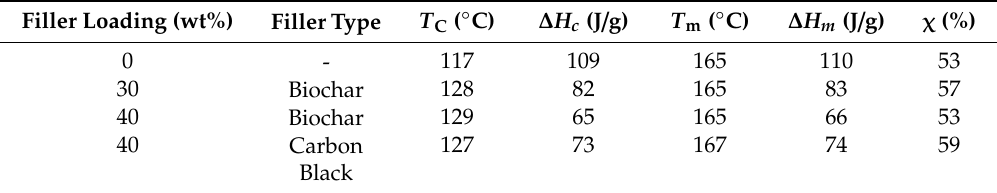
Table 3. Differential scanning calorimetry (DSC) data summary of biochar and carbon black containing composites.